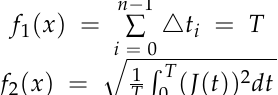
Figure 6. Partial function convergence curve: ( a ) function F1; ( b ) function F5; ( c ) function F7; ( d ) function F10; ( e ) function F13; ( f ) function F17.